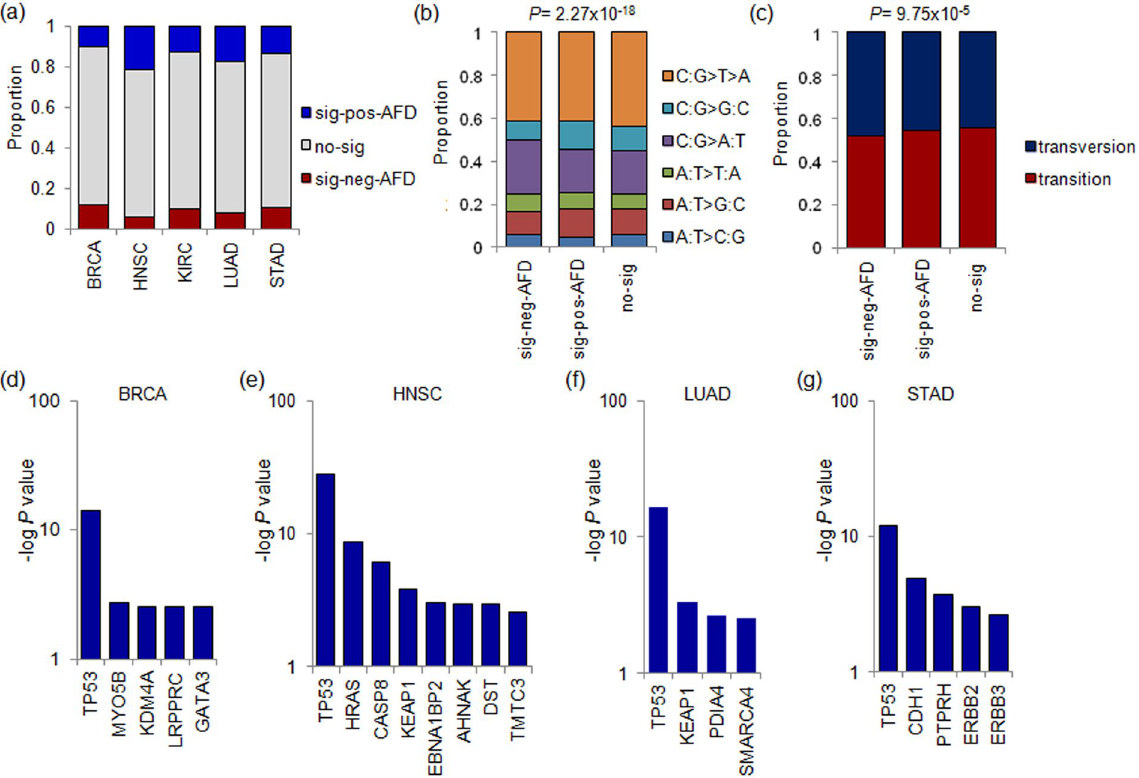
Figure 5. AI at missense mutations. ( a ) Barplots show the relative proportion of sig-pos-AFD (blue), sig-neg- AFD (red), and the other mutations (gray) for missense mutations across five tumor types. The proportion was calculated for events in copy number neutral segments. ( b ) The mutation spectra are shown for the sig-pos- AFD, sig-neg-AFD and the other mutations. P value was calculated by Chi-square test. ( c ) The proportion of the transversion and transition mutations are shown for sig-pos-AFD, sig-neg-AFD and the others. P value was calculated by Chi-square test. ( d ) Significance level of genes are shown for the enrichment of sig-pos- AFD missense mutations in BRCA. Y -axis is -log P value (Fisher’s exact test). Genes with -log P value > 2.5 are shown. Similarly shown for HNSC ( e ), LUAD ( f ) and STAD ( g ). KIRC has no genes to be plotted by the